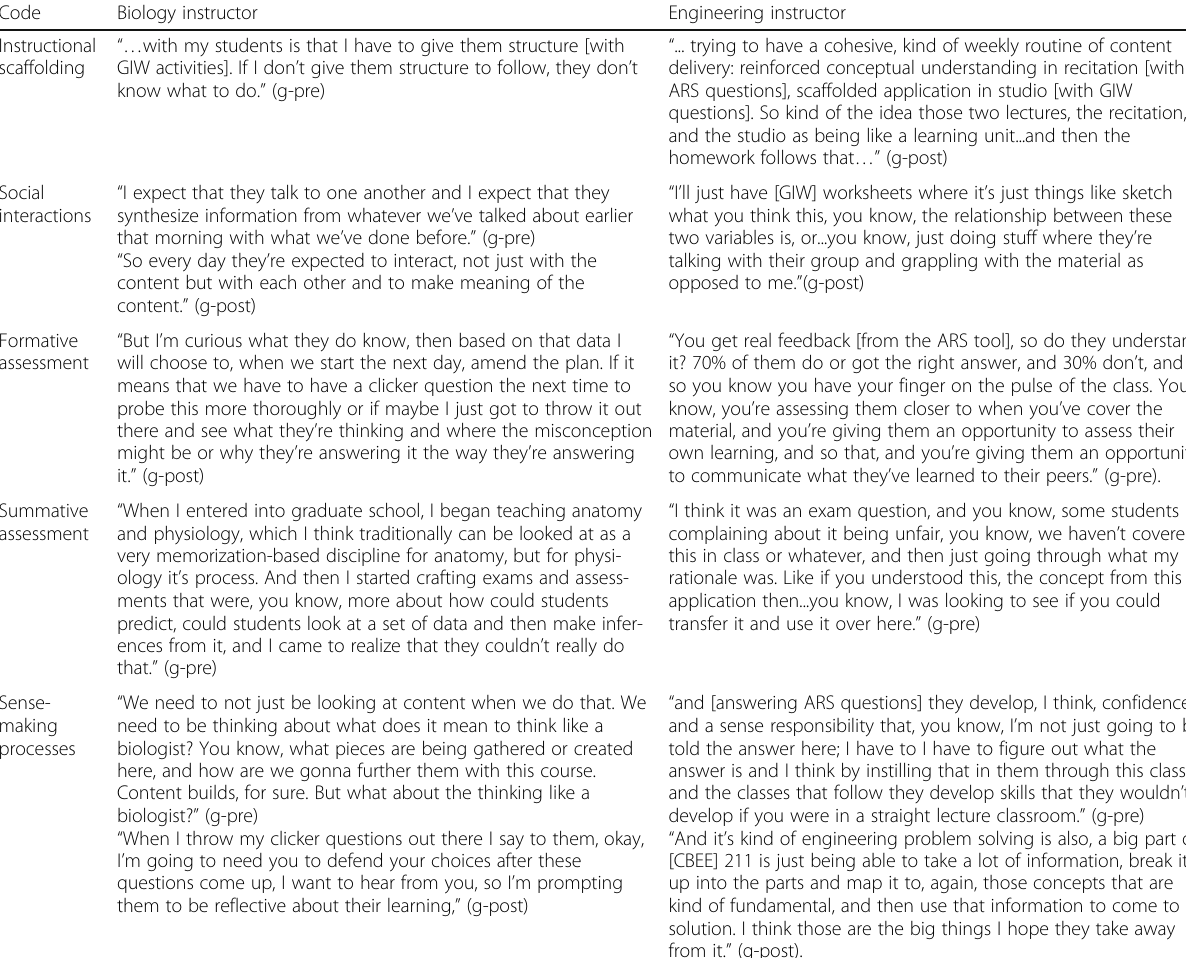
Table 4 Instructional system code categories and examples of corresponding beliefs from biology and engineering instructors Code Biology